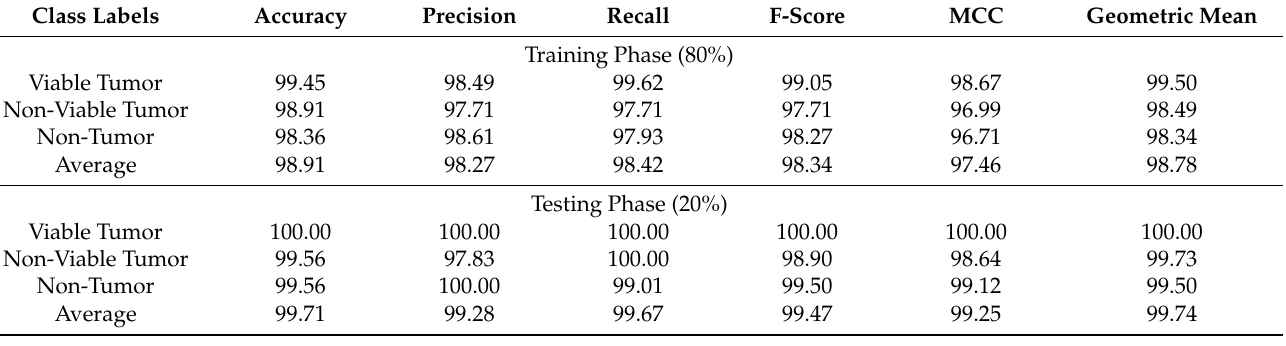
Table 1. Result analysis of WDODTL-ODC technique with various measures under 80% of TR and 20% of TS data.